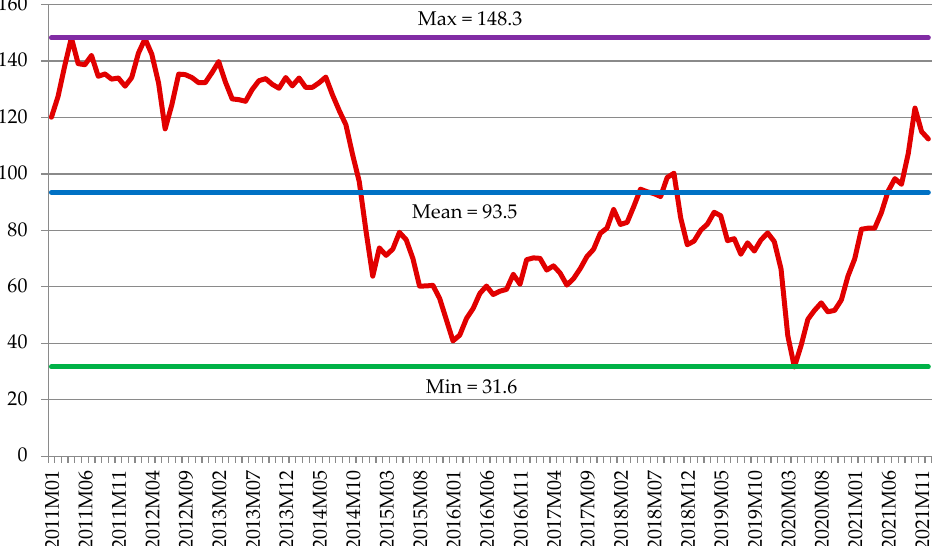
Figure 2. Monthly indices of world energy prices (based on nominal US dollars, 2010 = 100) and their variability in 2011–2021.